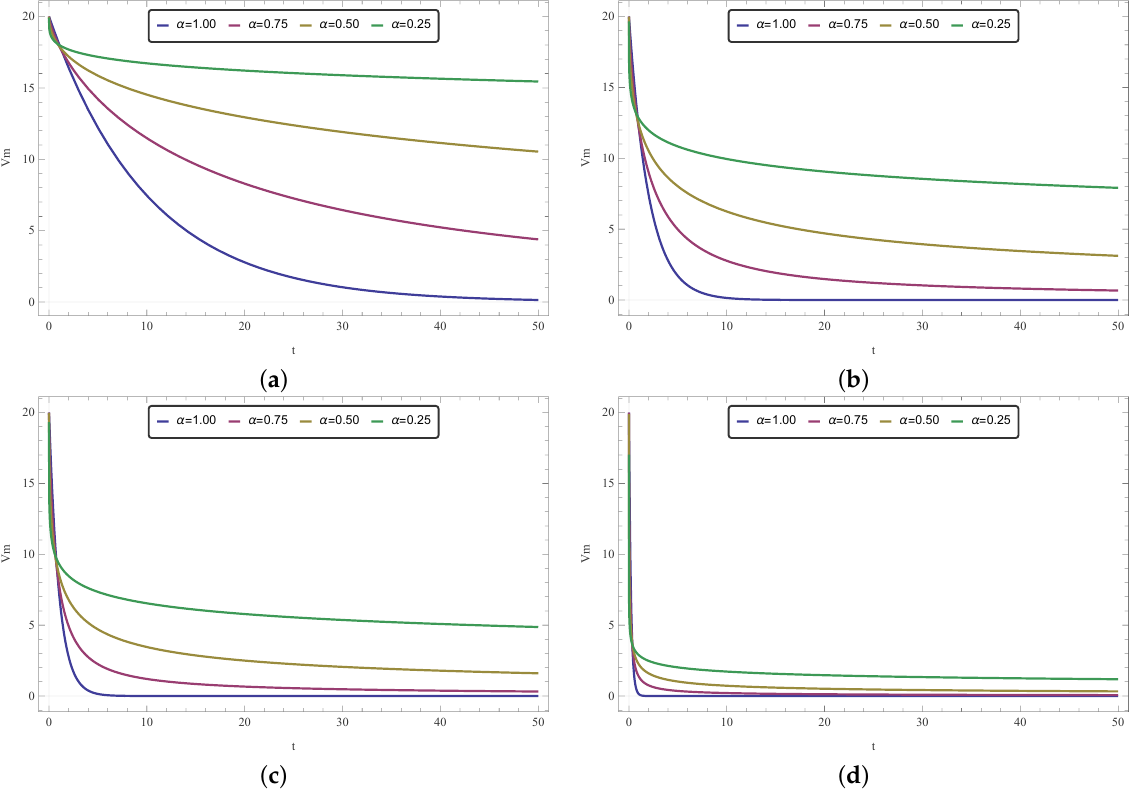
Figure 11. Time plots for Equation (10) with x = 0.5. Exploratory comparison between different values of α and k . ( a ) k = 1 × 10 − 2 mm 2 /ms, ( b ) k = 5 × 10 − 2 mm 2 /ms, ( c ) k = 1 × 10 − 1 mm 2 /ms, ( d ) k = 5 × 10 − 1 mm 2